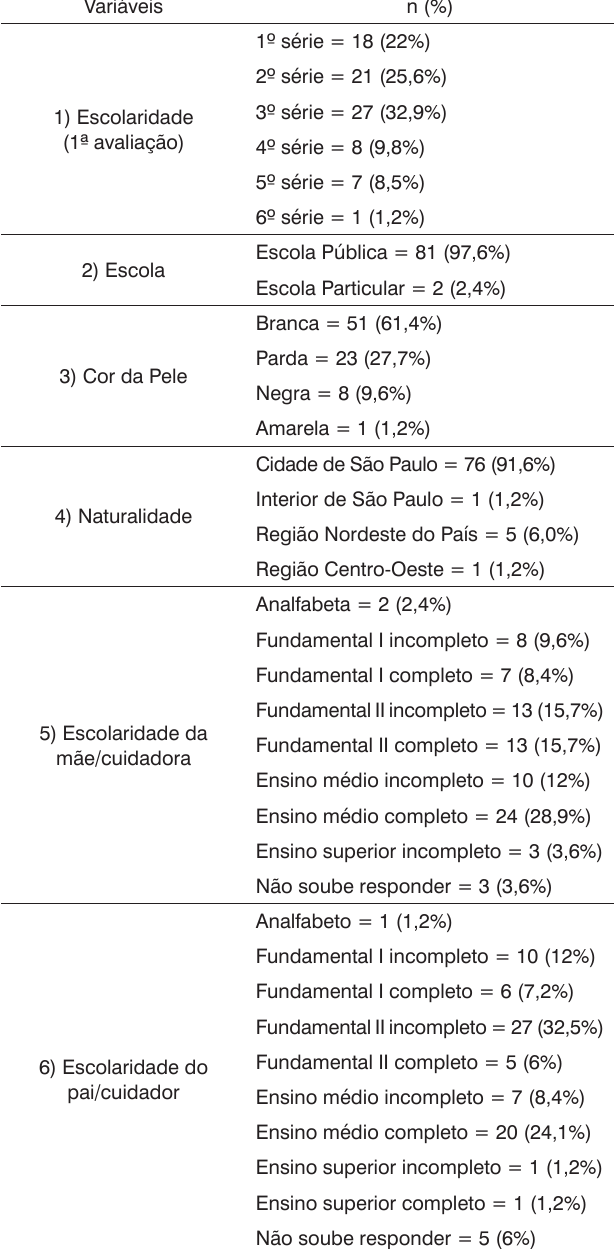
Tabela 1. Variáveis Sociodemográficas da amostra (n = 83).